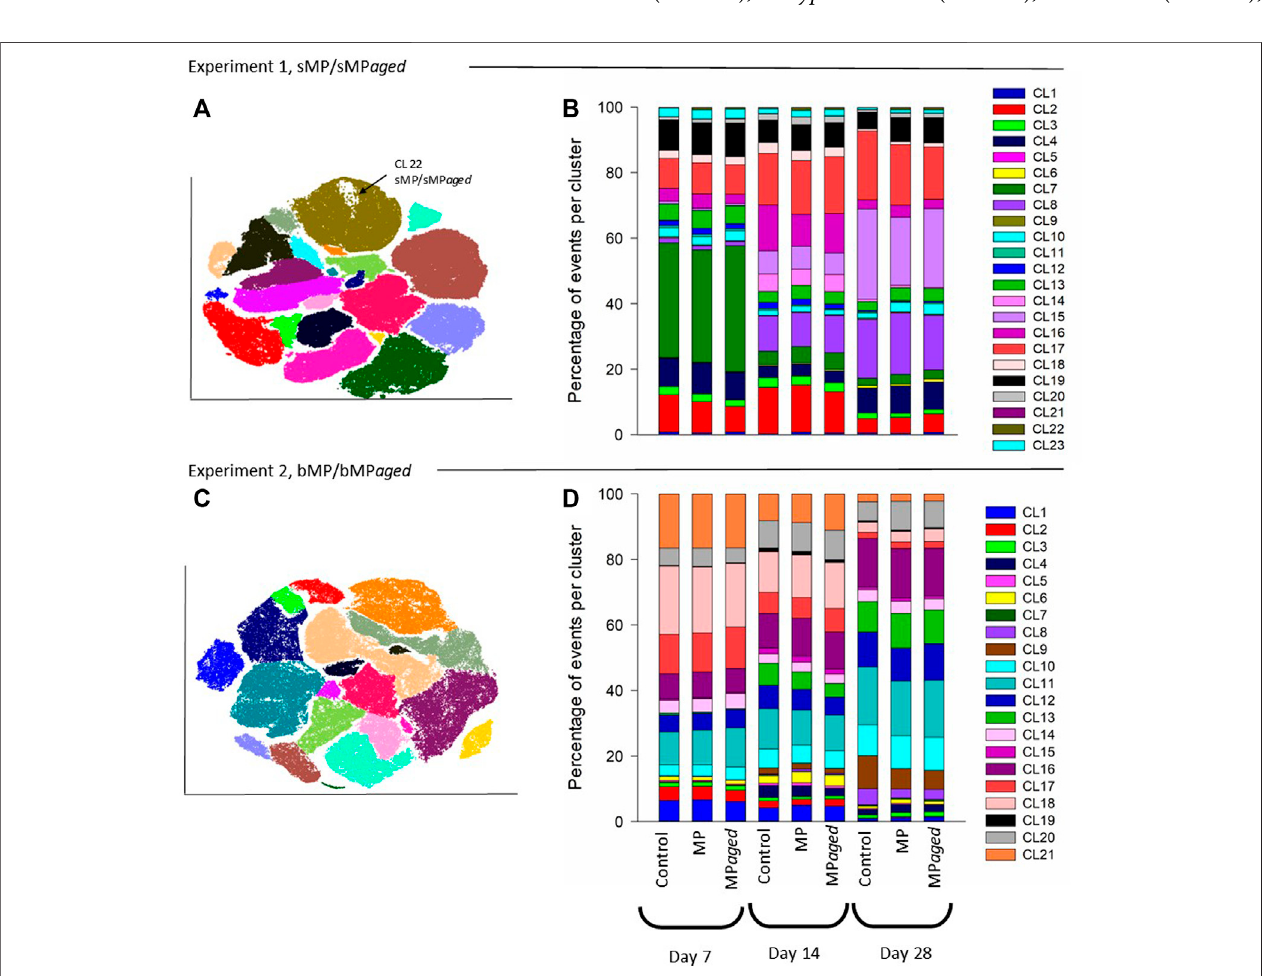
FIGURE 3 | Effects of sMP/sMP aged (A,B) and bMP/bMP aged (C,D) on the photoautotrophic community composition at day 7, 14, and 21 days of exposure. Control indicates periphyton grown in the absence of MP. Differences in community composition between treatments and time were analyzed using Adonis permutationalANOVA inR.Resultsindicatednosigni fi cantdifferencesbetweentreatments,while differencesovertimeweresigni fi cantinbothexperiments(experiment 1: p < 0.001, R 2 = 0.63 F = 36 and for experiment 2: p = 0.001, R 2 = 0.92, F = 282.3 in experiment 1 and 2, respectively).